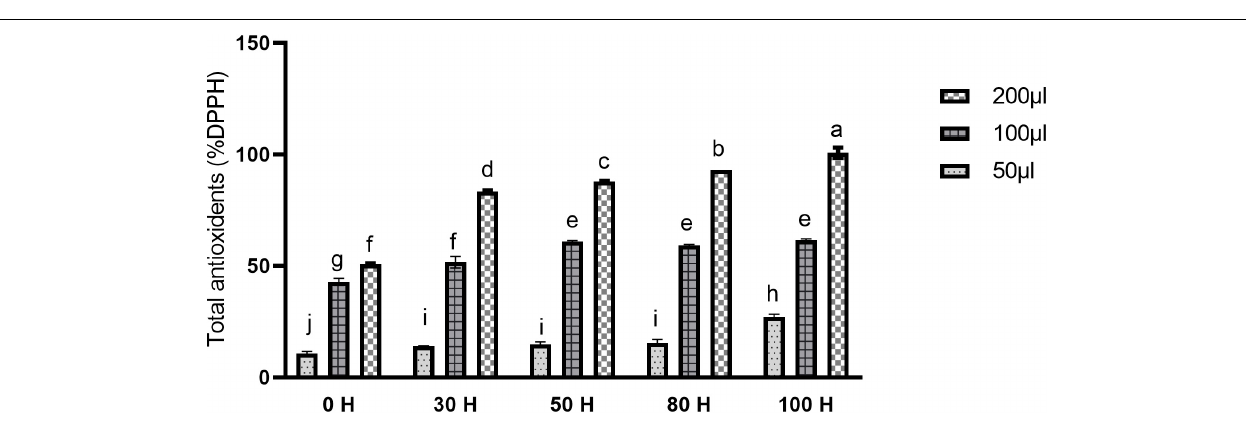
FIGURE 11 | Effect of LED light on Total antioxidants (%DPPH) in sweet cherry cv. “Van.” Data are average ± SE. Different letters represent significant difference between different time periods at 0.05 probability level (LSD